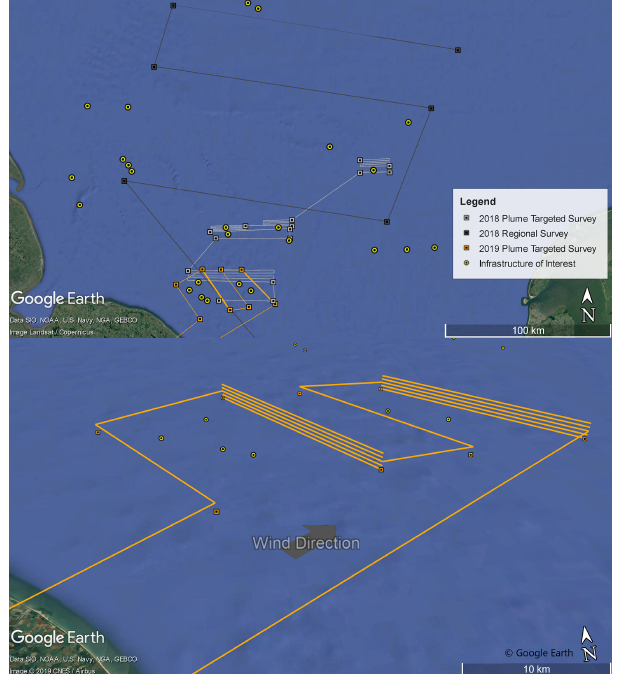
Figure 3. The top panel shows flight patterns of the regional and plume capture styles of flight deployed between 2018 and 2019, alongside infrastructure of interest (such as drilling rigs, gas distri- bution platforms or production platforms). The bottom panel shows a 2019 plume sampling survey of idealised stacked transects in the 2D plane downwind of infrastructure of interest. © Google Earth 2019 for background